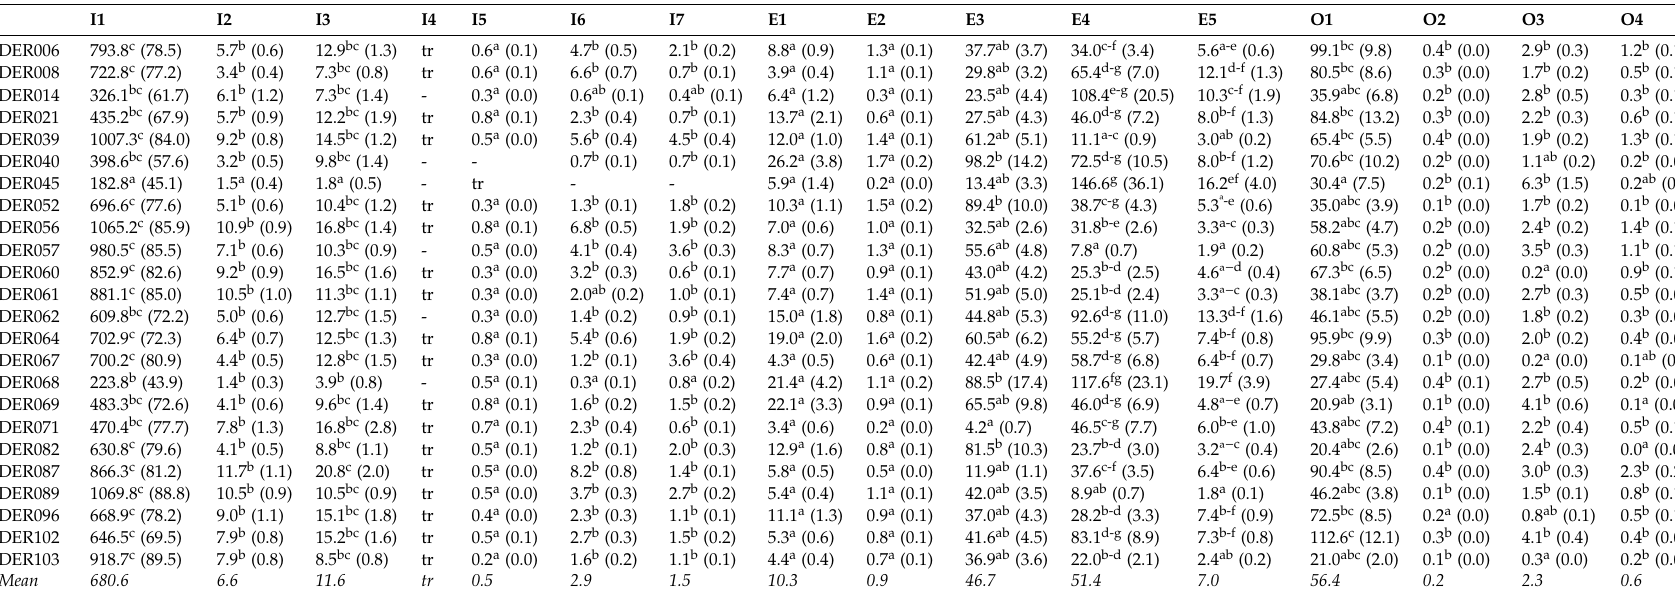
Table 4. Mean values (GC-peak area units, × 10 6 ) for the individual VOCs identified in the wall rocket materials ( n = 3). The relative abundances (%, in parentheses) are also